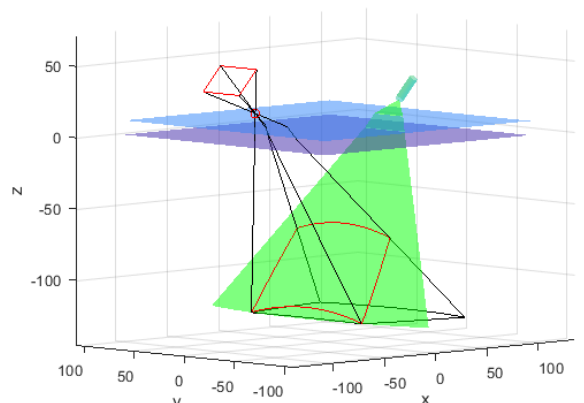
Figure 5: Measurement volume of a given camera-laser-set-up.